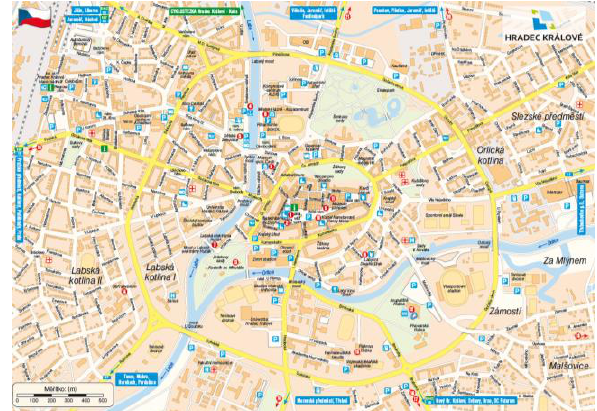
Figure 2. Example of a map preferred by users in aesthetics (map of Hradec Králové